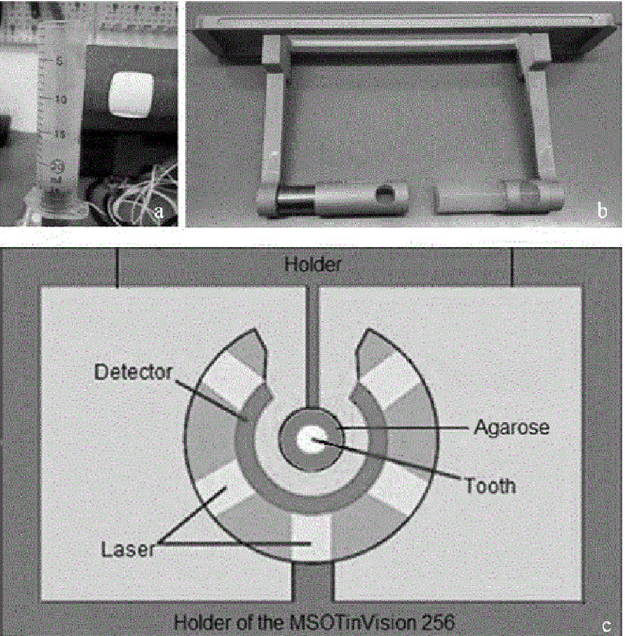
Fig 3. Experimental setup for PAT images. (a) The tooth was embedded in a solution of agarose and lipofundin in a plastic syringe. (b) Afterwards, the holder containing the solidified agarose and lipofundin mixture was attached to the MSOT inVision 256. (c) Schematic of the interior components of the MSOT inVision 256.